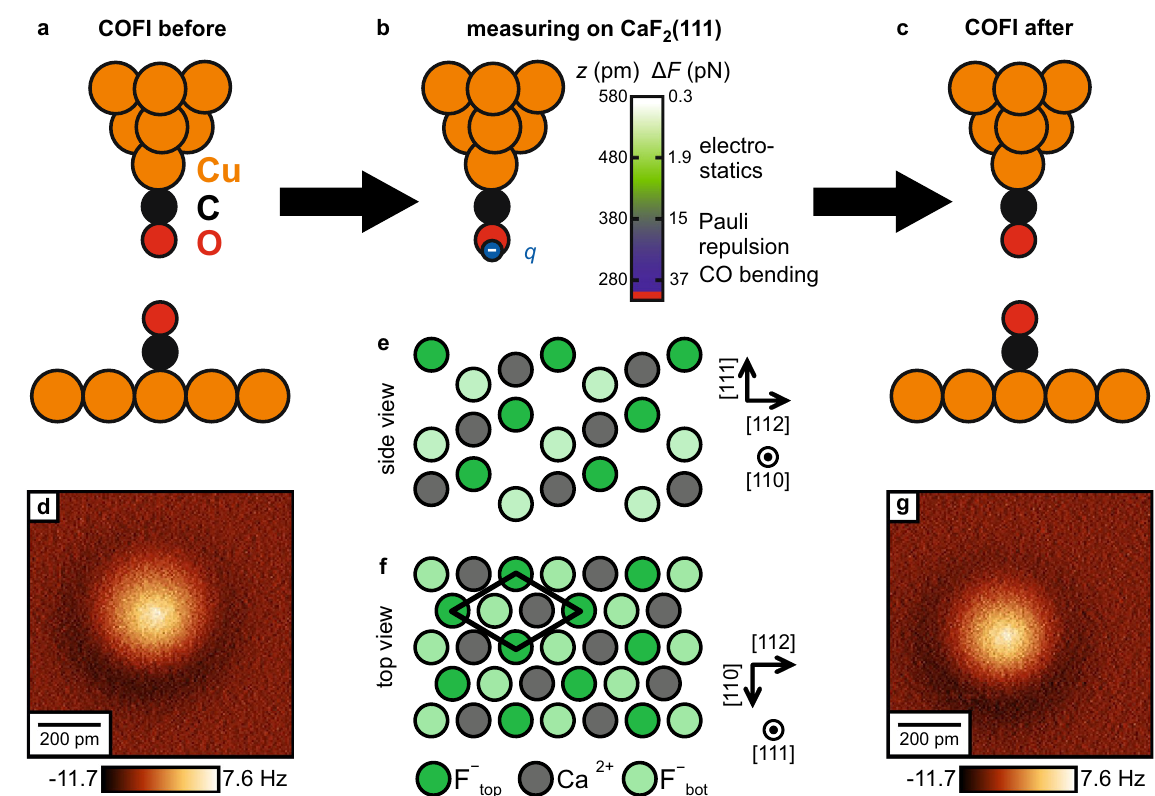
Figure 1. ( a – c ) Illustration of the measurement cycle in the experiment. After preparing and characterizing the tip on Cu(111) ( a ), the tip is transferred to a CaF 2 (111) sample for the measurements ( b ), and then again back to a Cu(111) sample to verify that the tip did not change during the whole experiment ( c ). The COFI images ( d , g ) recorded before and after the measurement on CaF 2 (111) show that the tip remained stable for the complete measurements. Imaging height: 70 pm retracted from the STM setpoint height on the bare Cu(111) surface, ( − 10 mV , − 100 pA ). ( b ) A CO-terminated tip has been modeled with a negative point charge q . Graph: Plot of the calculated force contrast (cid:31) F and responsible tip-sample interactions as a function of tip-sample distance z above CaF 2 (111). ( e , f ) Side and top view of the CaF 2 (111) surface, consisting of neutral F layers 32,39